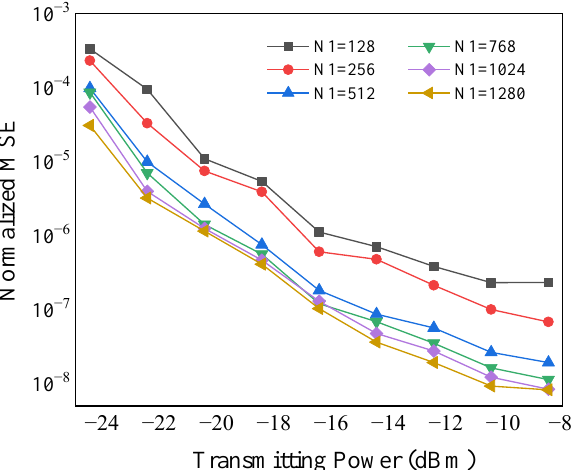
Figure 5. Normalized MSE as a function of the transmitting power for different N1 values.